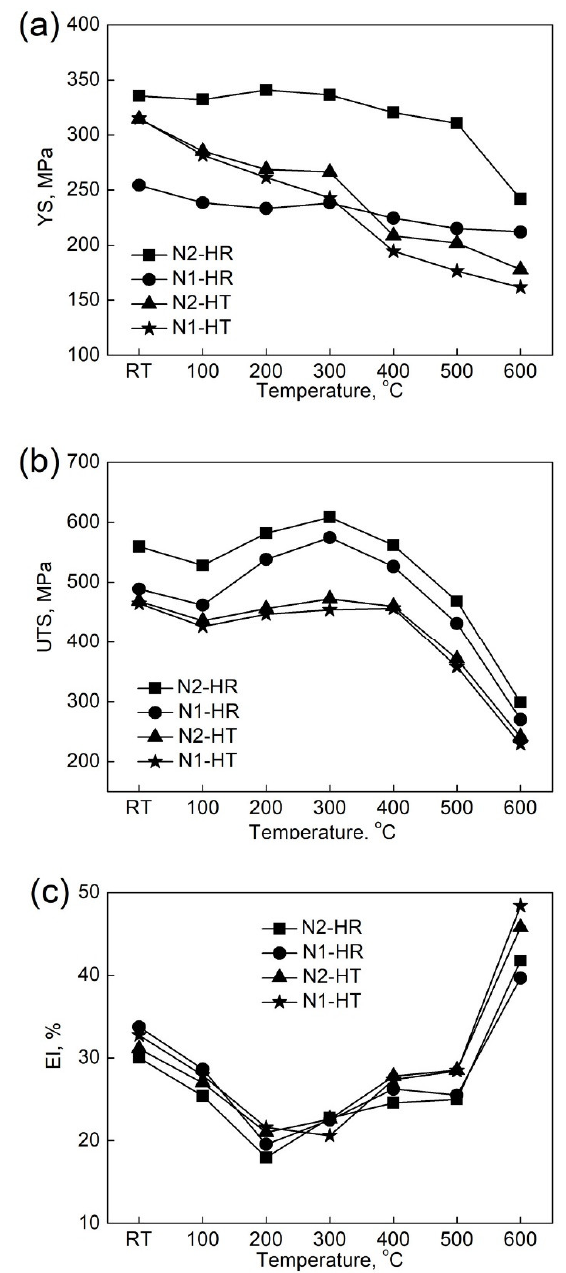
Figure 9. Effects of temperature (RT to 600 °C) on properties of steels: ( a ) yield strength, ( b ) tensile strength, ( c ) elongation.